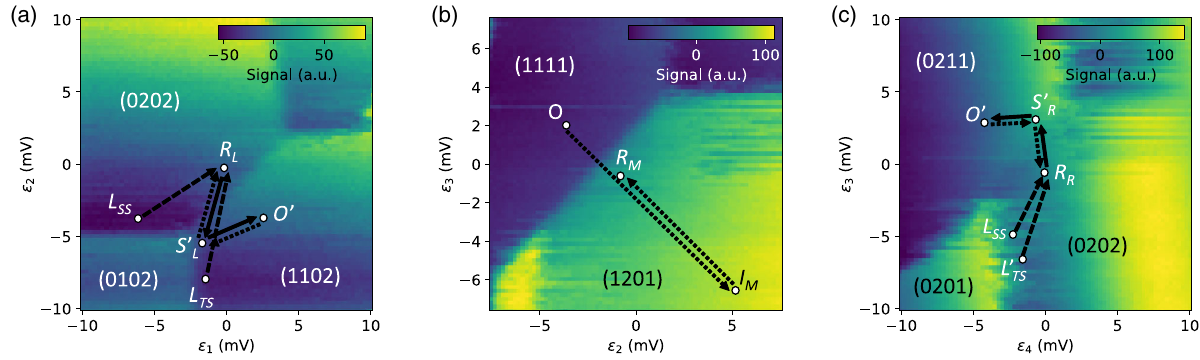
FIG. 7. Charge-stability diagrams for nearest-neighbor pairs, with (a) left, (b) middle, and (c) right. Pulse positions are indicated with small white circles and are labeled with a letter corresponding to the pulse stage in Table II. Primes are added to characters for which the indicated voltage position is a projection, because the true position is in a different charge occupation, which is outside the respective two-dimensional plane in the four-dimensional charge-stability space. Solid arrows represent the part of the pulse sequence for which only one variant is used, though the operation voltage position O is varied throughout the experiments. Dashed arrows correspond to sequences for initialization of either a singlet-singlet L or triplet-singlet L . Dotted arrows correspond to sequences for readout (and SS TS isolation) of either the middle pair, R ( I ), or readout (and isolation) of the left pair, R ( S 0 ), and the right pair, R ( S 0 M M L R L